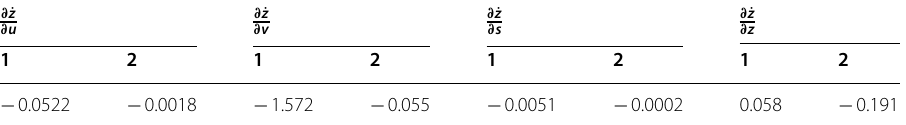
Table 19 Partial derivatives of ˙ z at unstable stationary state X b 40 and under the second AHB for b critical =